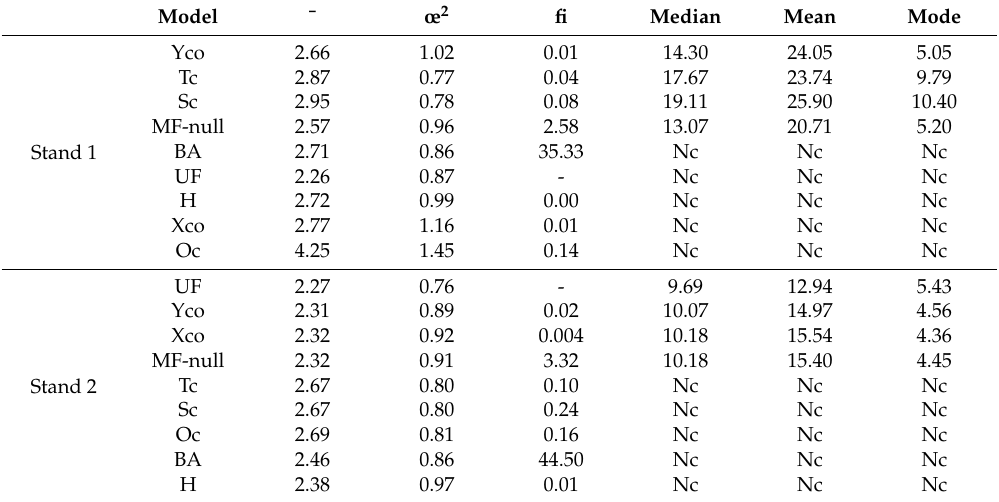
µ , σ 2 : Dispersal kernel parameters, β : parameter of the fecundity model; Nc: Not considered (average dispersal distances (median, mean and mode) are estimated only for models showing a ∆ k smaller than the one for the null model of the corresponding